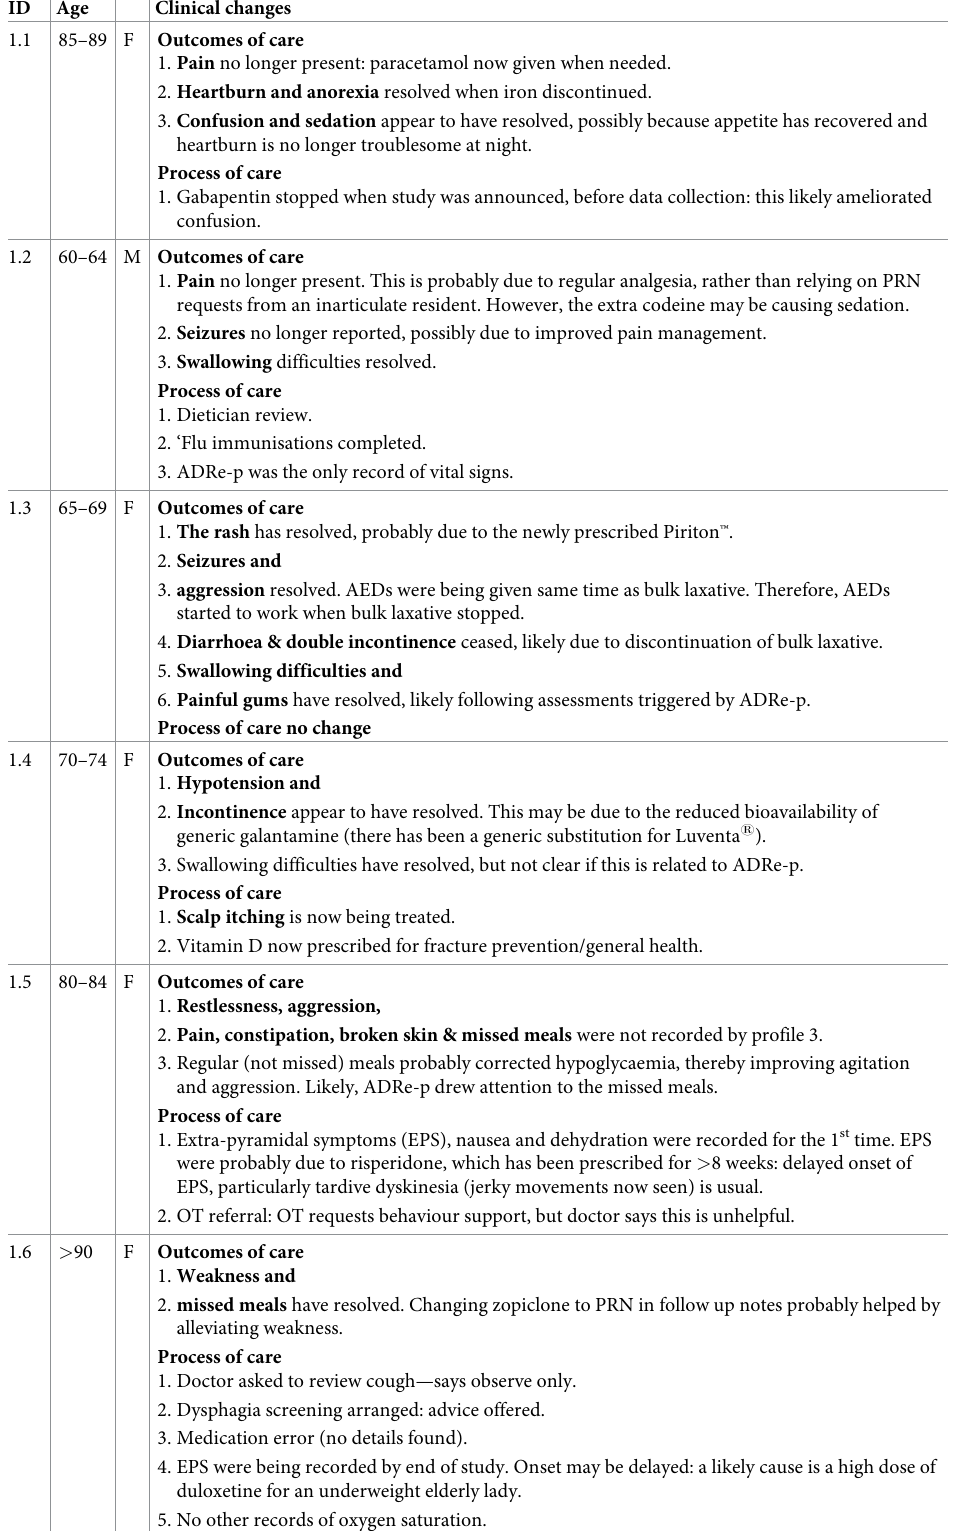
Table 3. Clinical gains for residents: Comparison of first with final ADRe-p profiles (n =